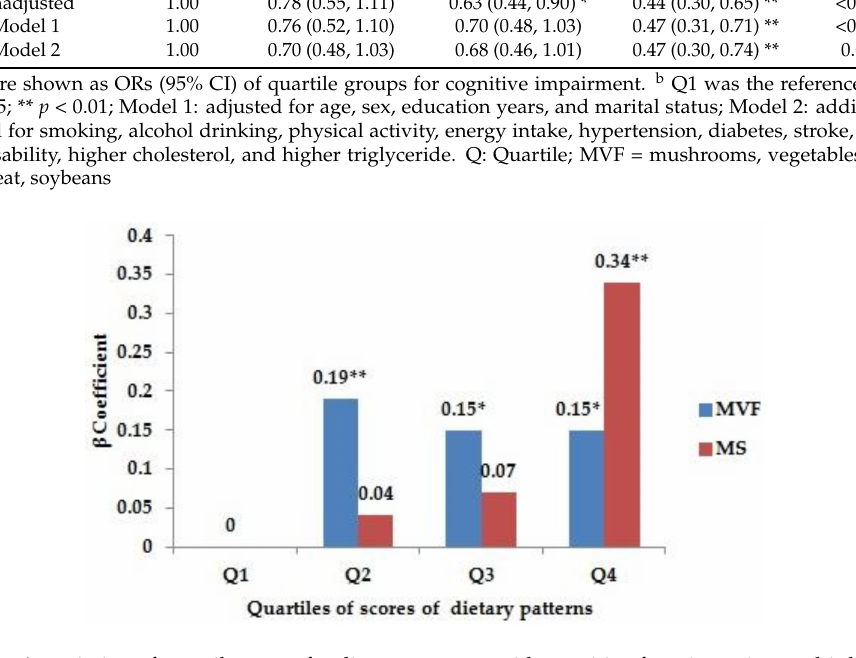
Figure 1. Association of quartile scores for dietary patterns with cognitive function using multiple linear regression a,b,c . a data shown are β coefficients of quartile scores for cognitive function. b The original MMSE score was transformed as –log (31-MMSE score). c Models were adjusted for age, sex, education years, marital status, smoking, alcohol drinking, physical activity, energy intake, hypertension, diabetes, stroke, obesity, ADL disability, high cholesterol, and high triglyceride. * p < 0.05; ** p < 0.01; ADL: Activities of daily living; Q: Quartile; MVF = mushrooms, vegetables, fruits; MS = meat, soybeans; MMSE: Mini-Mental State